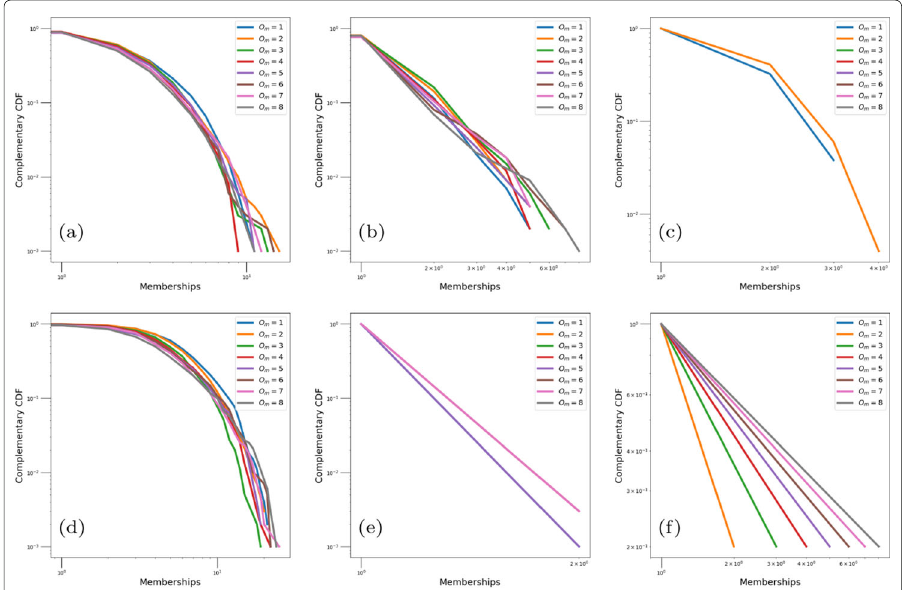
Fig. 14 Variation of the maximum number of memberships ( O m ) for LFR synthetic networks considering the membership of nodes: a Bigclam; b CFinder; c Copra; d Demon; e SLPA; f